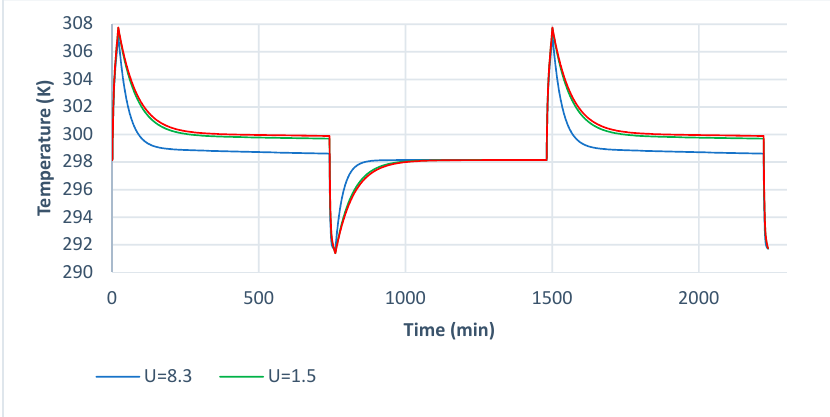
Figure 12. Gas temperature trend for the First Configuration varying the Transmittance of the tank.